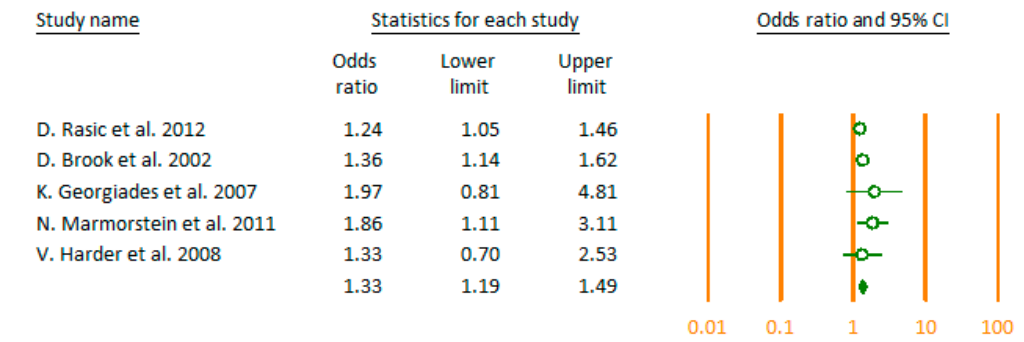
Figure 2. Examining the directionality in longitudinal studies (forest plots A–C).